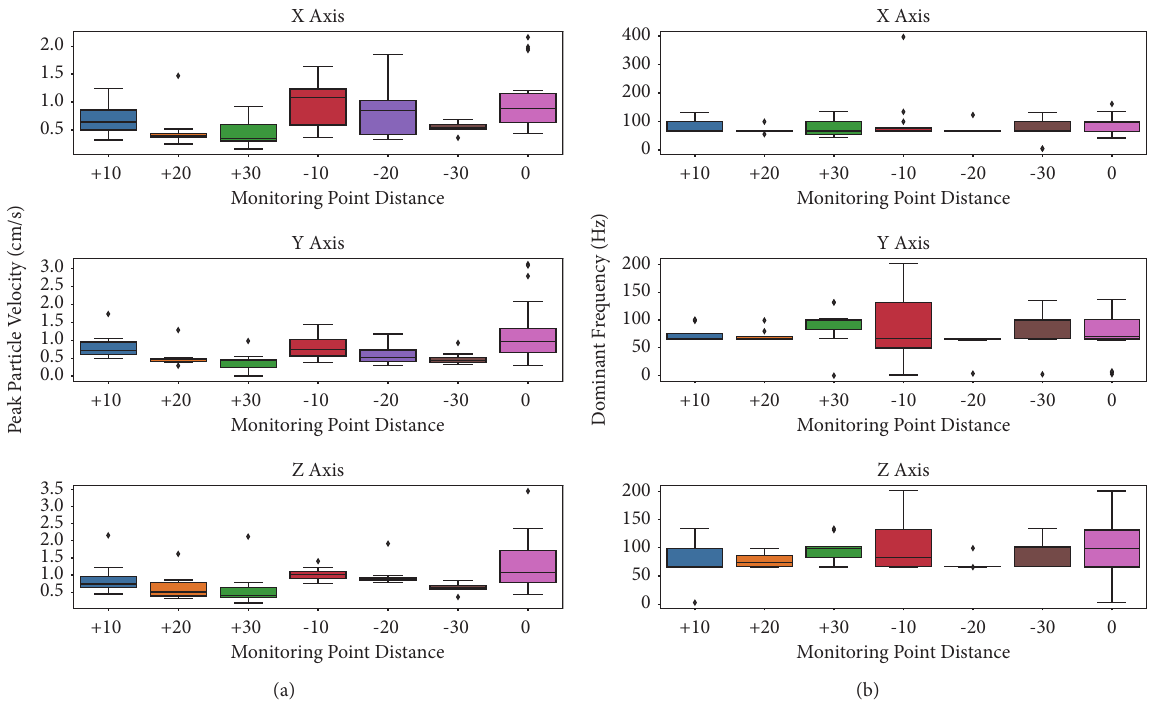
Figure 11: PPV and dominant frequency box plots: (a) PPV; (b) dominant